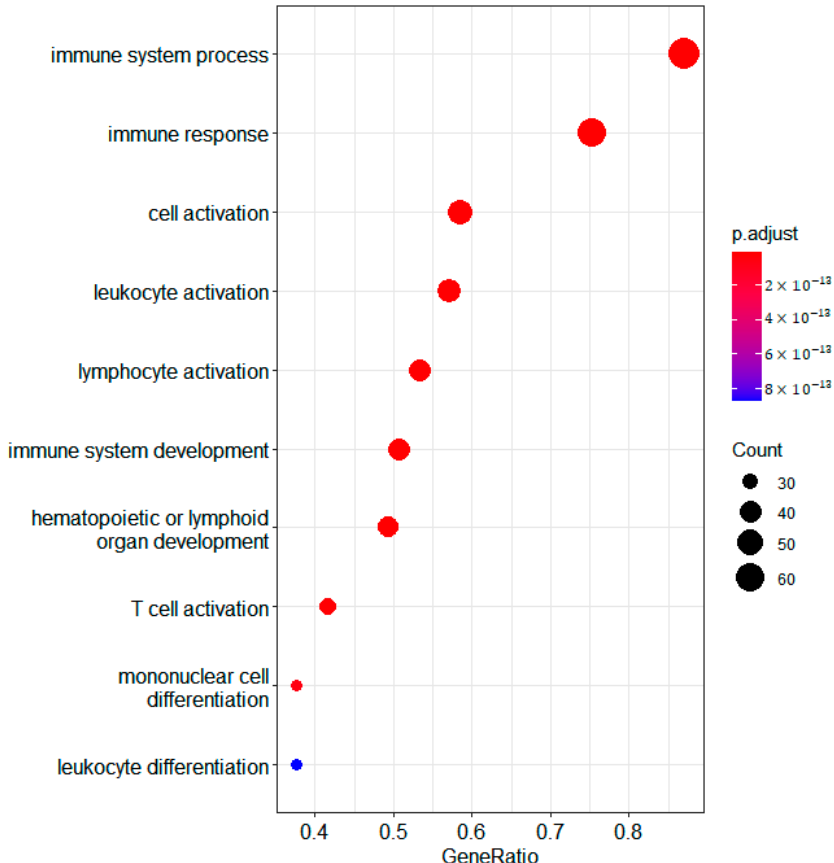
Figure 2. Bubble plot of differentially expressed genes in the RNA domain detected using samR. GO biological process terms for genes overexpressed in jSVD cluster 2 compared to clusters 3 and 1 are shown.